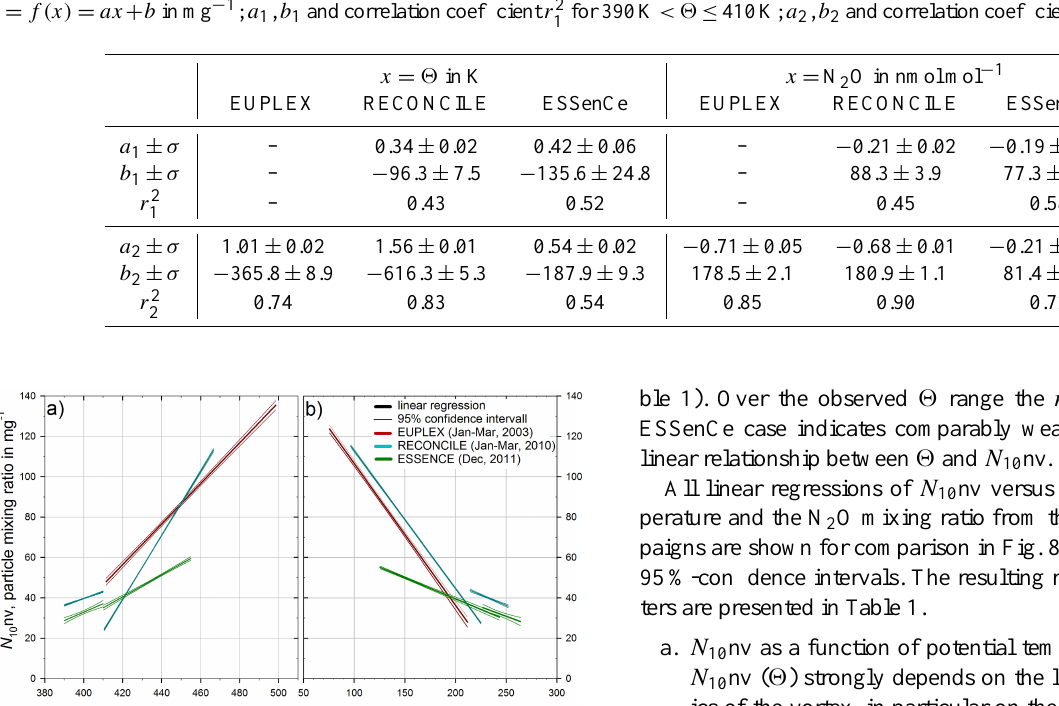
Table 1. Parameterization with standard error ( σ) of the linear regression between the particle mixing ratio N 10 nv with potential temperature (cid:50) and with N 2 O mixing ratio for different altitude ranges, (cid:50)< 410K and (cid:50)> 410K, respectively, within the vortex as displayed in Fig. 8. y = f (x) = ax + b in mg − 1 ; a 1 , b 1 and correlation coefficient r 2